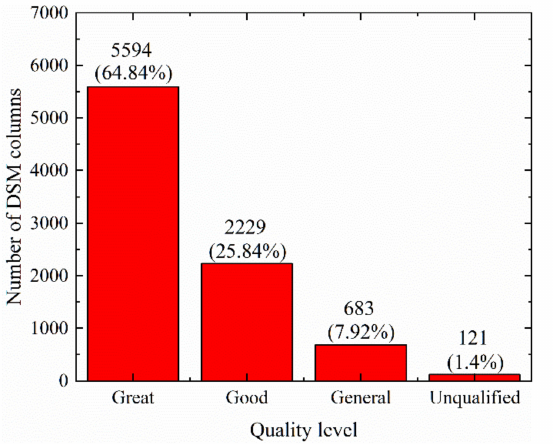
Figure 7. The distribution of quality levels among DSM